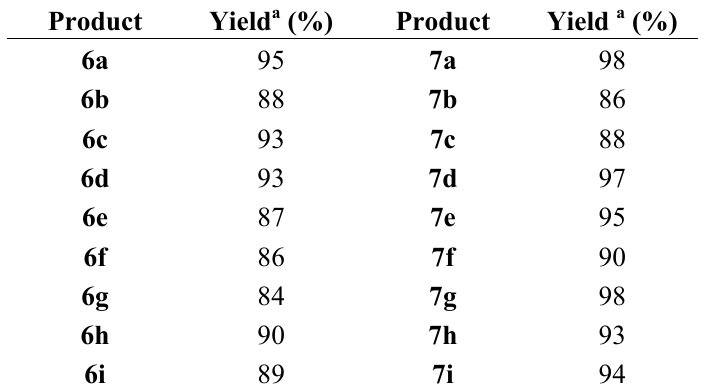
Table 1. Synthesized 1,2,3-triazoloquinazolines 6a – i and 7a – i .